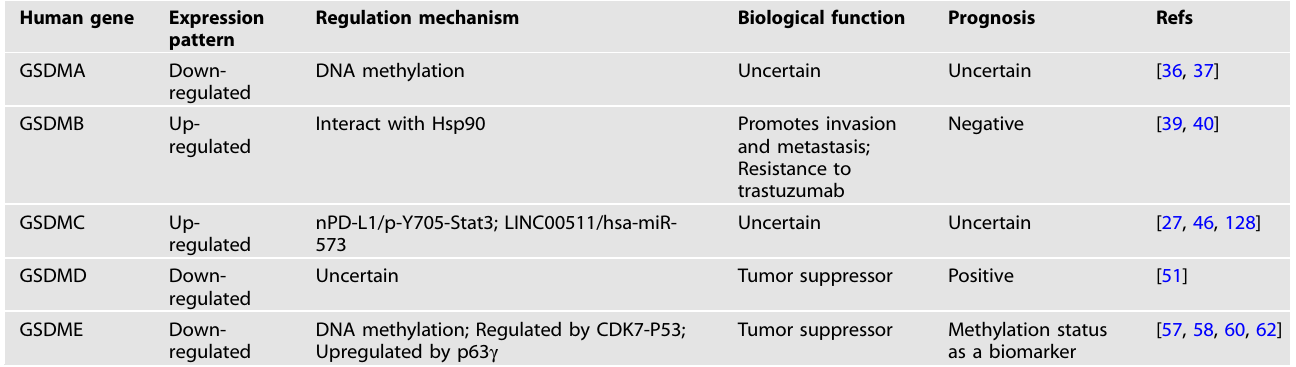
Table 1. The expression and function of GSDM family members in breast